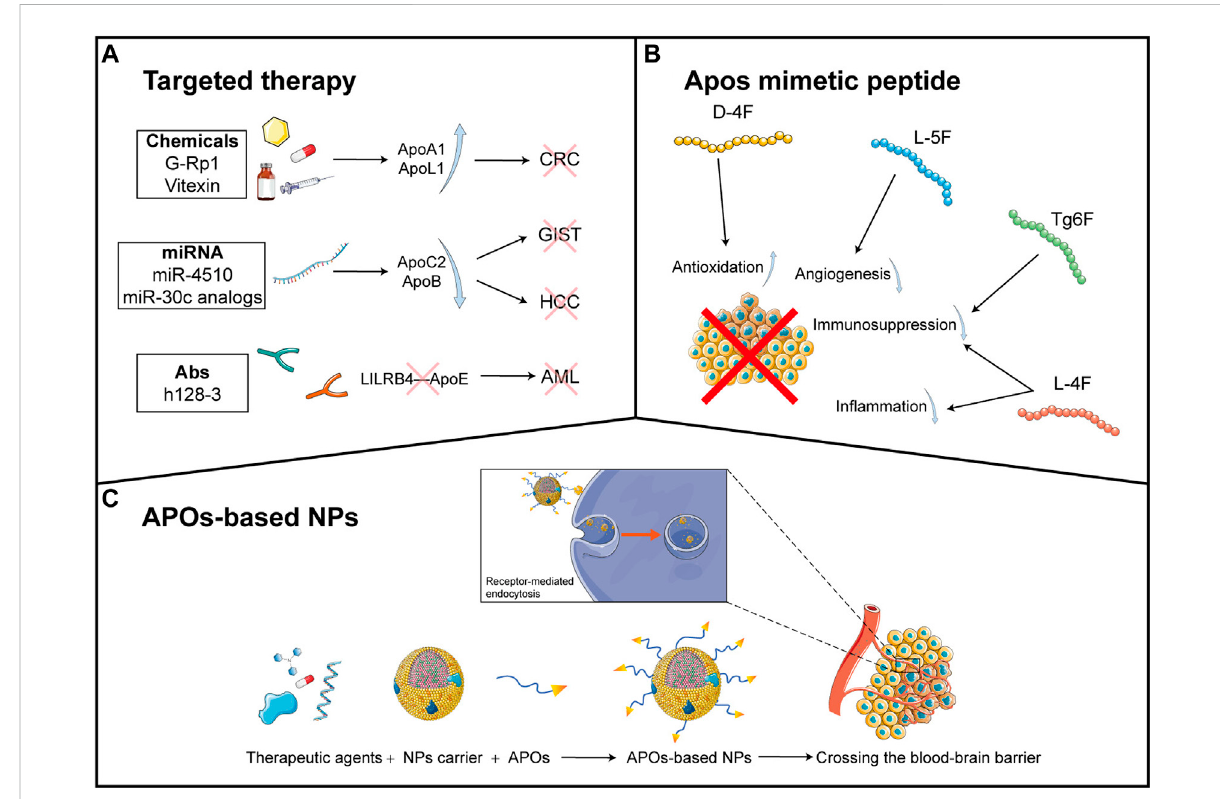
FIGURE 3 APO-related anti-cancer therapies (A) : The current anti-cancer therapeutic agents targeting APOs are divided into three types: chemicals, miRNA and antibodies. Chemicals such as G-RP1 and vitexin induce the upregulation of ApoA1 and ApoL1, respectively, which inhibit CRC proliferation. miRNA agents include miR-4510 and miR-30c analogs, which downregulate the expression of ApoC1 and ApoB respectively. These eventually hamper the development of GIST and HCC. Antibodies such as h128-3 can bind LILRB4 and thereby disrupt the interaction of LILRB4 and ApoE, preventing the progression of AML (G-Rp1: Ginsenoside Rp1; CRC: colorectal cancer; miRNA: microRNA; GIST: gastrointestinal stromal tumor;HCC:hepatocellularcarcinoma;AML:acutemyeloidleukemia.) (B) :Apolipoproteinmimeticpeptides showanti-tumoreffects. D-4F inducesantioxidation whileL-5Finducesangiogenesis.BothL-4FandTg6Fpromoteimmunosuppression,andL-4Falsofacilitatesin fl ammation.All of these events trigger tumor-killing effects (C) : The general components of APOs-based NPs include therapeutic agents in the core of NPs, NPs carrier, and APOs conjugated on the surface of NPs. The therapeutic agents include chemotherapeutic drug (the capsule), small molecular inhibitor (the irregular polygon), oligonucleotide miRNA inhibitor (the single strand nucleotide chain), and photosensitizer (the chemical structural formula). Due to the ability of APOs to bind to receptors of some biological barrier and cells, the NPs can cross the blood-brain barrier (BBB) and trigger the receptor-mediated endocytosis to facilitate the targeted delivery of therapeutic agents into cancer cells, achieving enhanced anticancer outcome (NP: Nanoparticles). This fi gure is partially made using Servier Medical Art